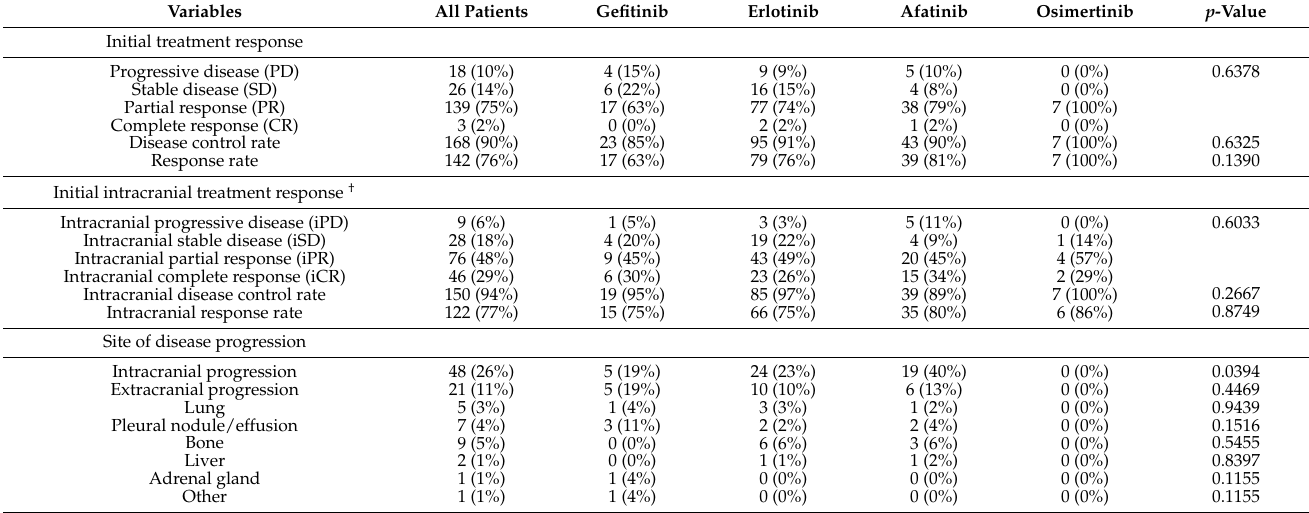
Table 2. Initial treatment response and site of disease